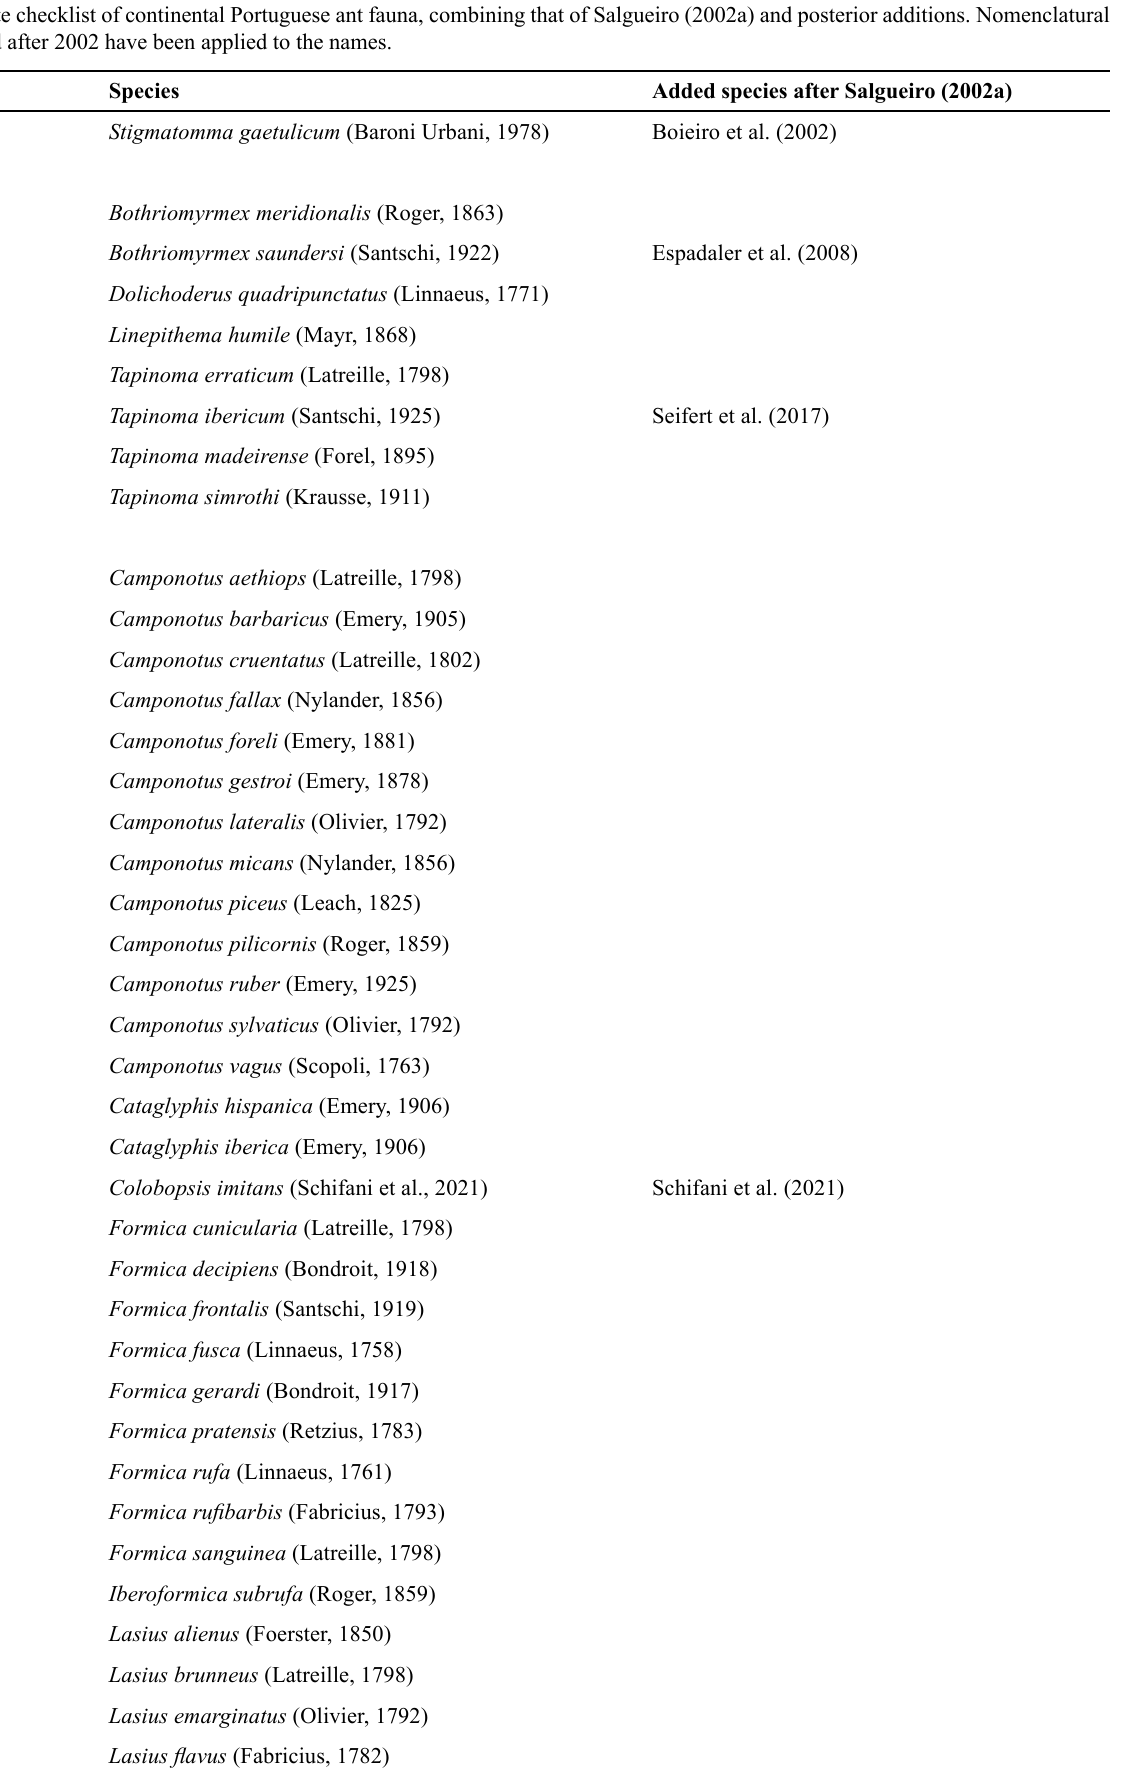
Table 3 . Complete checklist of continental Portuguese ant fauna, combining that of Salgueiro (2002a) and posterior additions. Nomenclatural changes proposed after 2002 have been applied to the names.